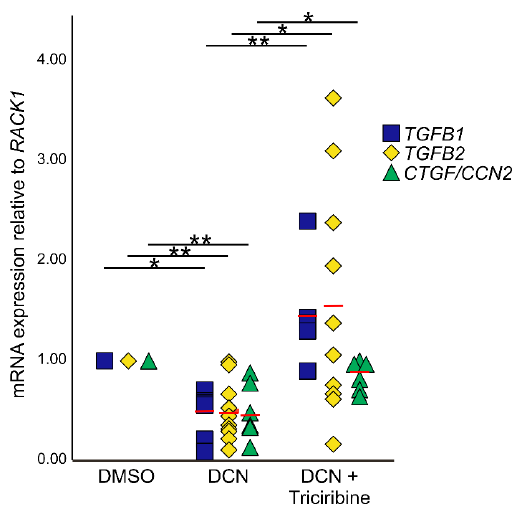
Figure 7. Inhibition of the pAKT/AKT signaling pathway circumvents negative regulation of TGF- β and CTGF/CCN2 by DCN. After treatment with DCN expression of TGF-β1 (0.44 ± 0.10, n = 6, p ≤